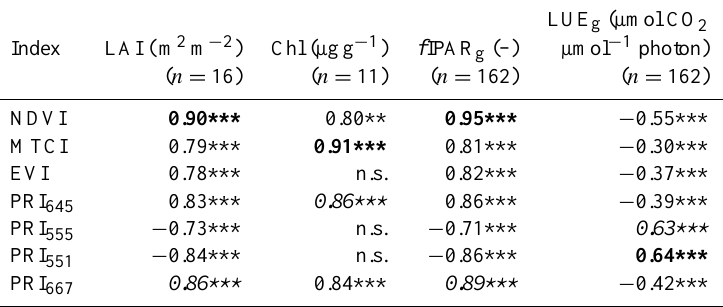
Table 2. Coefficients of correlation ( r ) between the HSI VIs and ancillary and eddy data (LUE g ) measured at the study site. n is the number of samples for each correlation analysis. The VI best-correlated with each variable is in bold print; the second most correlated is in